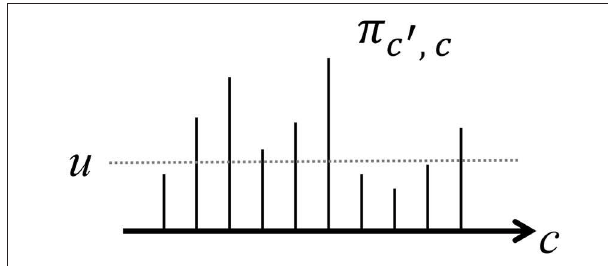
FIGURE 7 | Slice sampling truncates the number of classes by thresholding π c ′ , c .